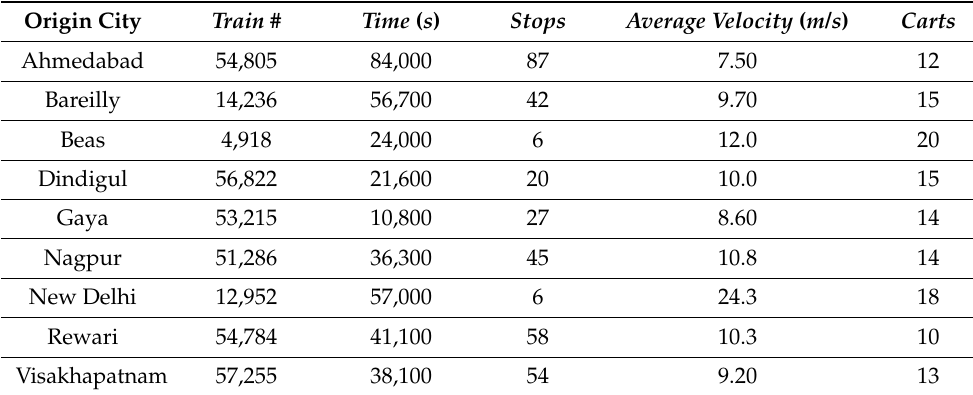
Table 1. Sample of Indian Rail Info